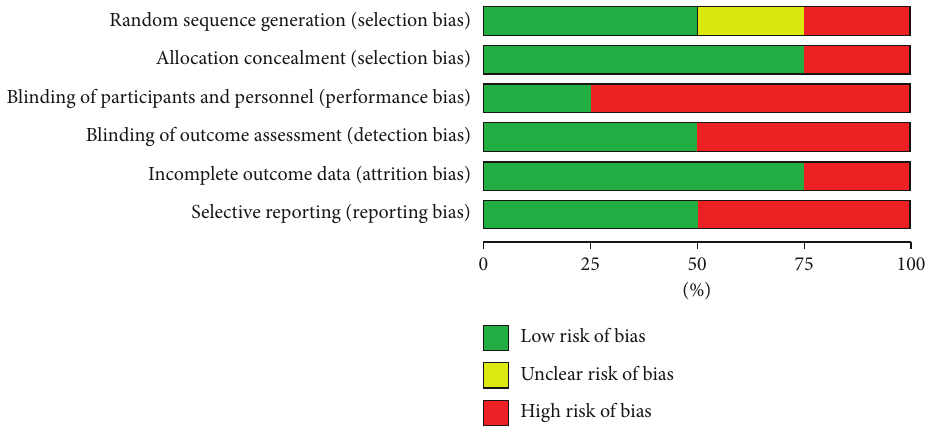
Figure 13: Risk of bias graph: review authors’ judgments about each risk of bias item presented as percentages across all included studies. Table 3: Modified Newcastle-Ottawa Quality Assessment Scale for the included observational studies. Selection